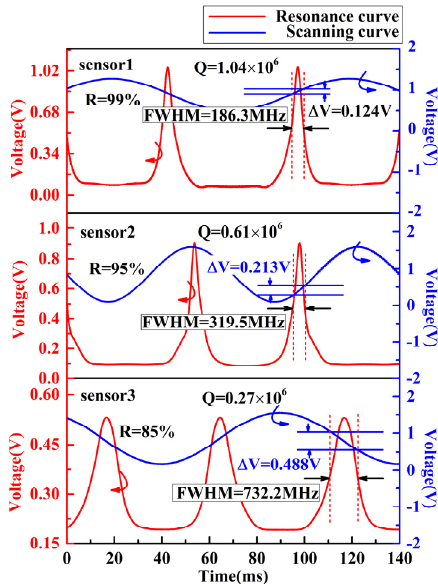
Figure 8. The resonance spectrum of the used FPEs with reflectivity of 99%, 95% and